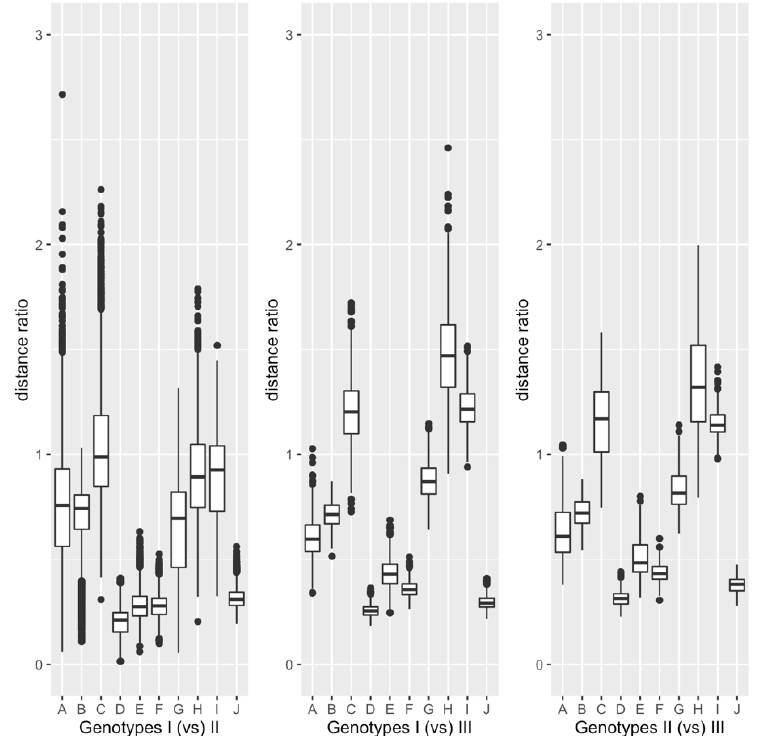
Figure 4. Box plots of the ten distance ratios between genotypes. The ordinate indicates the values of the distance ratios. The symbols on the abscissa, A – J, correspond to ed bp ( x , y )/ ed nbp ( x , y ), ed bp ( x , y )/ ed ( x , y ), ed nbp ( x , y )/ ed ( x , y ), ed bp ( x , y )/ K c s ( x , y ) , ed nbp ( x , y )/ K c a ( x , y ) , ed ( x , y )/ K c a ( x , y ) , ed bp ( x , y )/ K c a ( x , y ) , ed nbp ( x , y )/ K c s ( x , y ) , ed ( x , y )/ K c s ( x , y ) , and K c a ( x , y ) / K c s ( x , y ) . See legend of Figure 3 for the explanation of box plot.